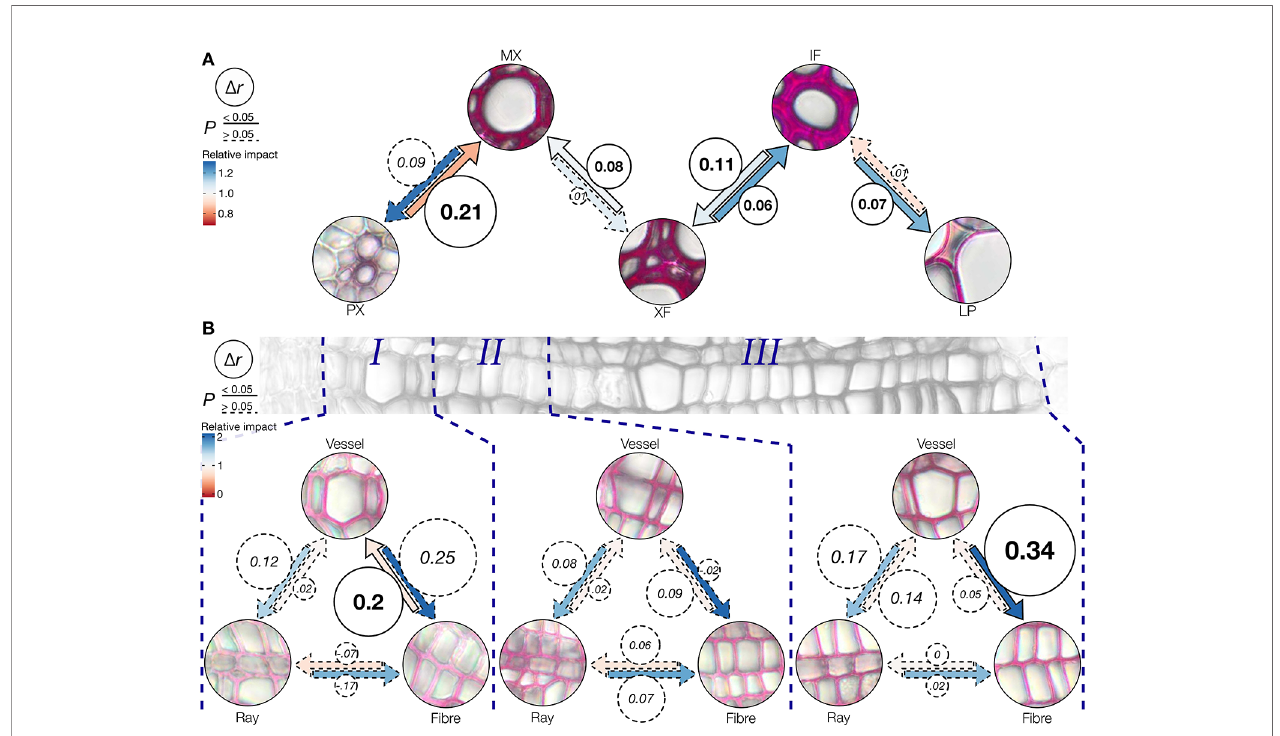
FIGURE 8 | Effect of neighboring cell types on coniferaldehyde incorporation. (A) Schematic representation of the effect of neighboring cells on the accumulation of coniferaldehyde in speci fi c cell types in 11 Arabidopsis WT and LOF lines (underlying correlations are shown in Figure S10 ). D r is shown in circles and coded in circle area and represents the changes in the Pearson correlation coef fi cient when the cell type at the tip of the arrow is directly adjacent to the cell type at base of the arrow. Statistically signi fi cant (William's test, a = 0.05) D r values are indicated by continuous arrow and circle outlines. The color of the arrows represents the relative impact (fold change in absorbance) on the cell type at the tip of the arrow when adjacent to the cell type at the base of the arrow. (B) Cell type-speci fi c effects of adjacent cell types to the response to the Wiesner test in three genotypes of poplar along xylem development. D r , signi fi cance, and relative impact are coded analogous to panel (A)